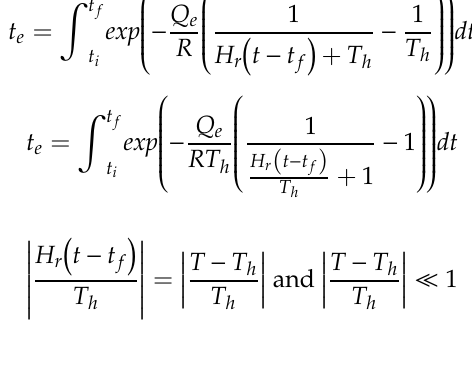
Table 5. Microstructural characteristics of the SLMed IN718 for different heating rates.